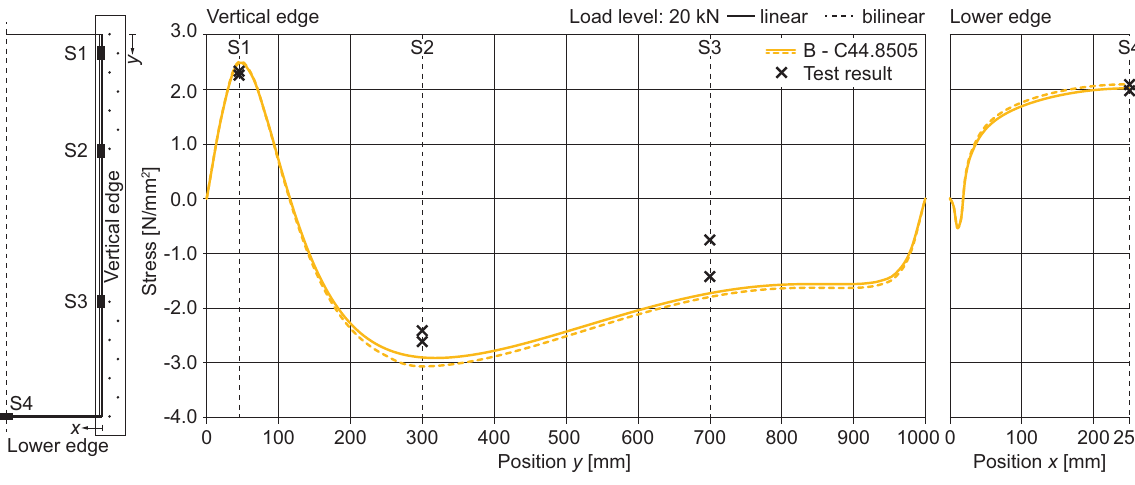
Fig. 14 Calculated stresses along the vertical and the lower horizontal glass edge for B – nolax C44.8505 compared to measured values at the strain gauge